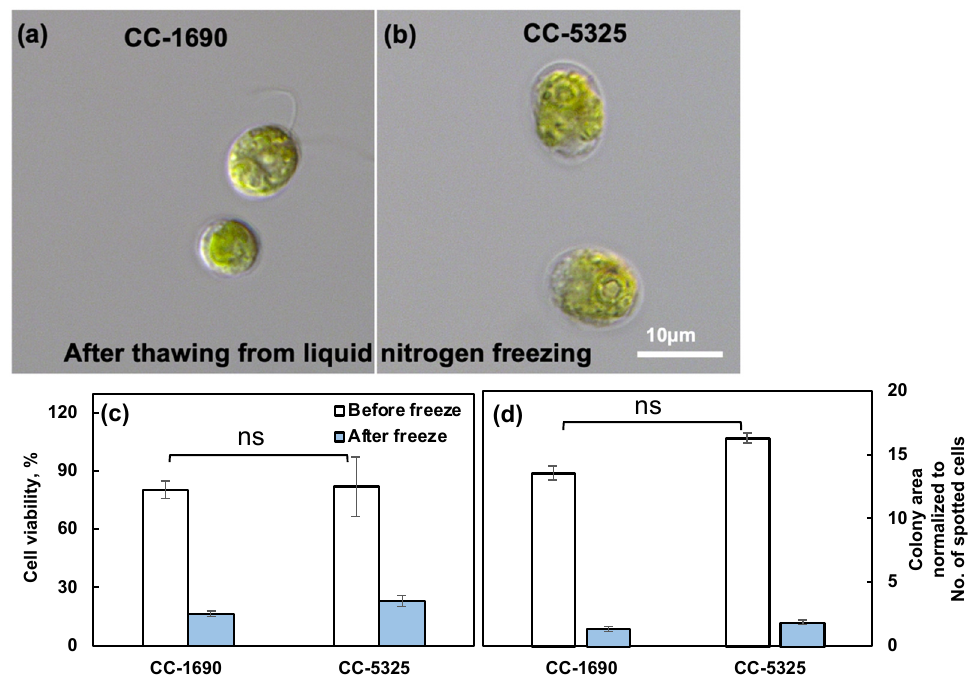
Figure 6. CC-1690 and CC-5325 recovered from liquid nitrogen freezing equally well. ( a , b ) Rep- resentative images of CC-1690 and CC-5325 after thawing from liquid nitrogen freezing. ( c ) Cell viability before and after freezing quantified by the No. of colonies on TAP plates. ( d ) Colony area on TAP plates for cells before and after freezing, normalized to the total number of cells spotted for each condition. The numbers of intact cells before and after freezing in liquid cultures were measured using a Coulter Counter and diluted cultures were spotted on TAP plates. TAP plates with algal spots were grown at 25 °C under 150 μ mol photons m − 2 s − 1 white LED lights for 44-h before plate imaging. Colony numbers and areas were quantified using ImageJ. Cell viability was calculated by the No. of colonies on TAP plates divided by the No. of cells spotted. Mean ± SE, N = 3 biological replicates. Statistical analyses were performed using a two-tailed t -test assuming unequal variance by comparing the two strains under the same experimental conditions. No significant differences between these two strains under the same conditions; ns, not significant, p > 0.05.